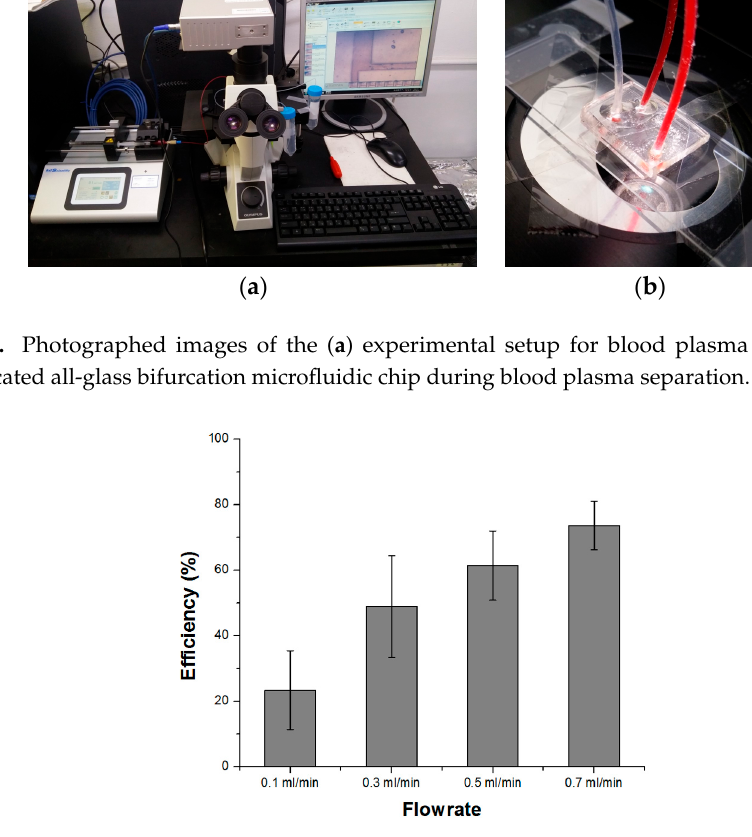
Figure 8. Blood plasma separation efficiency with various flow rates in the fabricated all-glass microfluidic chip with diluted and defibrinated sheep blood.